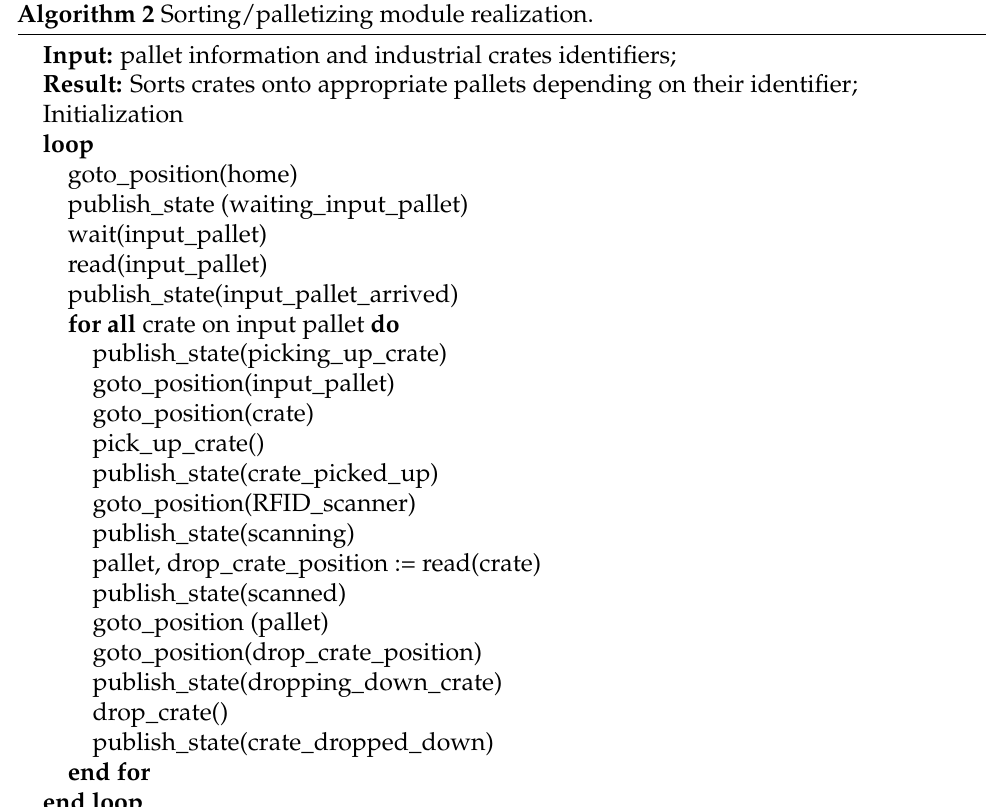
Algorithm 2 Sorting/palletizing module